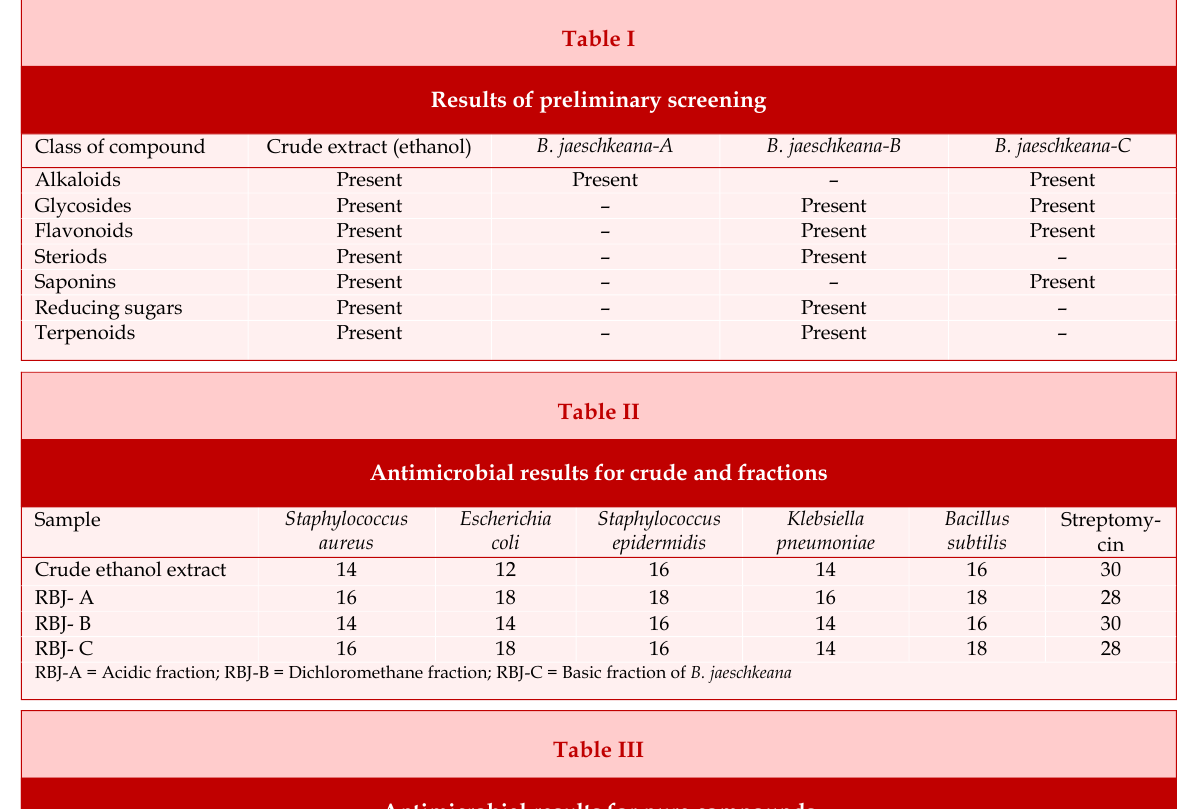
Antimicrobial results for pure